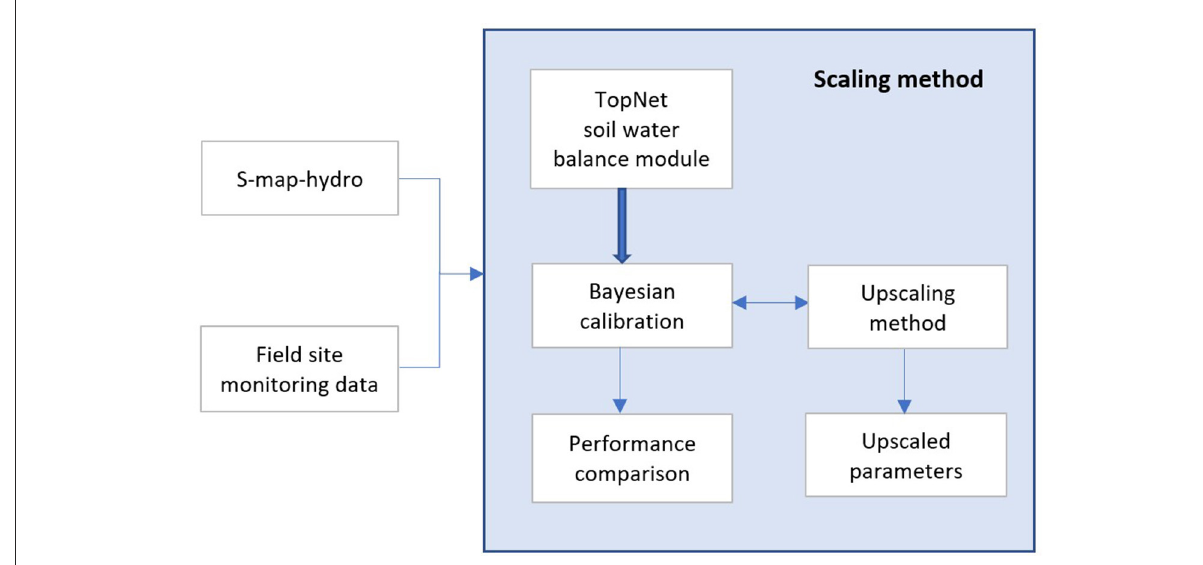
FIGURE1 Conceptual model for upscaling soil hydraulic